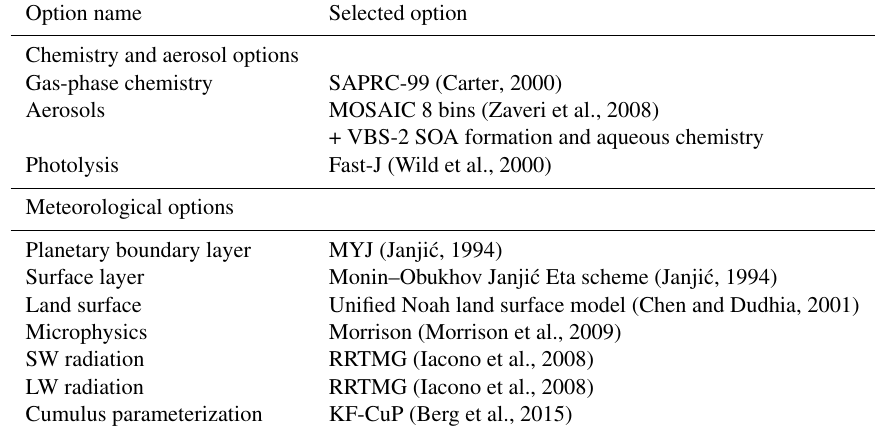
Table 1. WRF-Chem 3.5.1